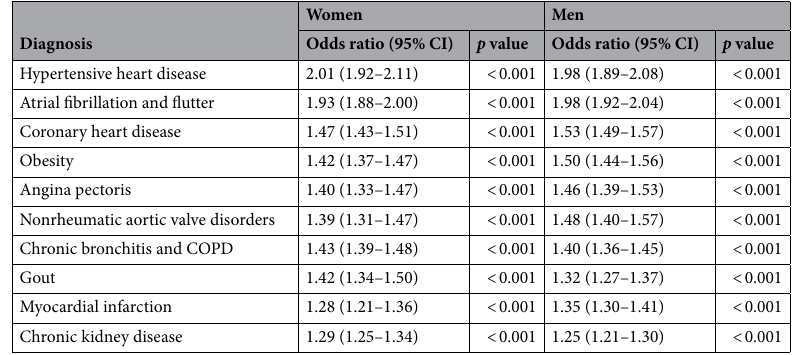
Table 3. Association between top 10 risk diagnoses and heart failure in female and male patients followed in general practices in Germany (multivariable logistic regression